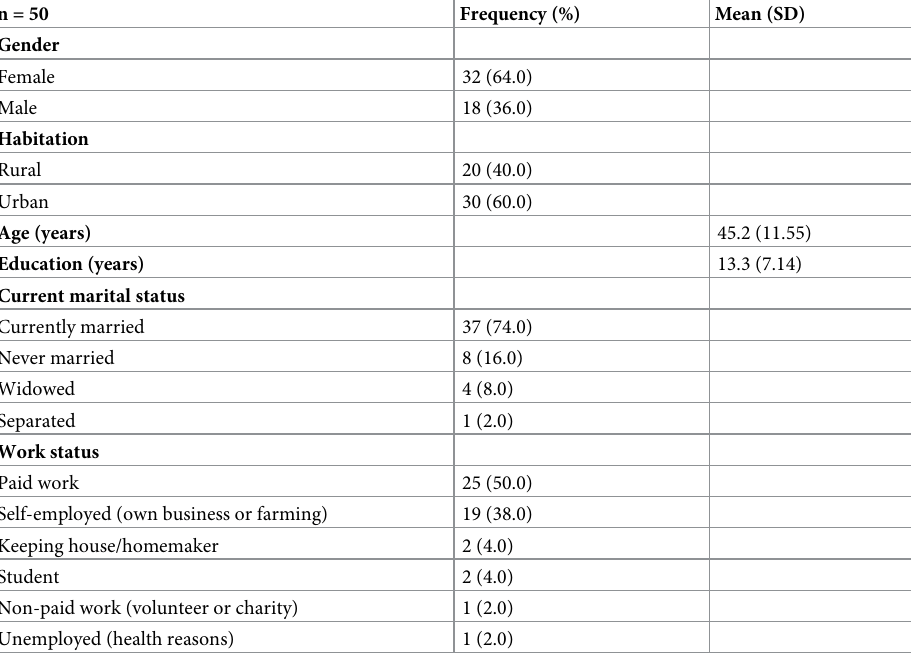
Table 2. Demographic characteristics of participants that completed test-retest reliability